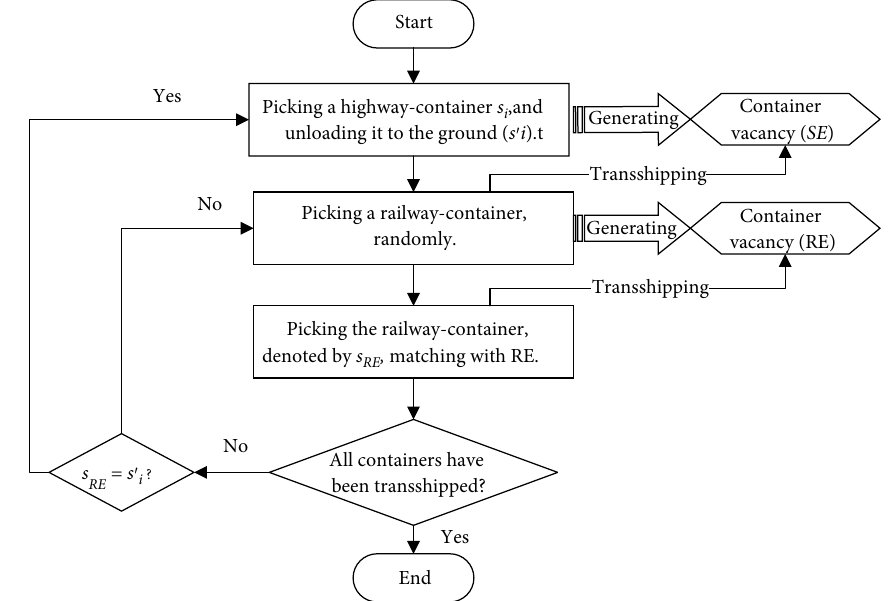
Figure 2: The flow chart for gantry cranes’